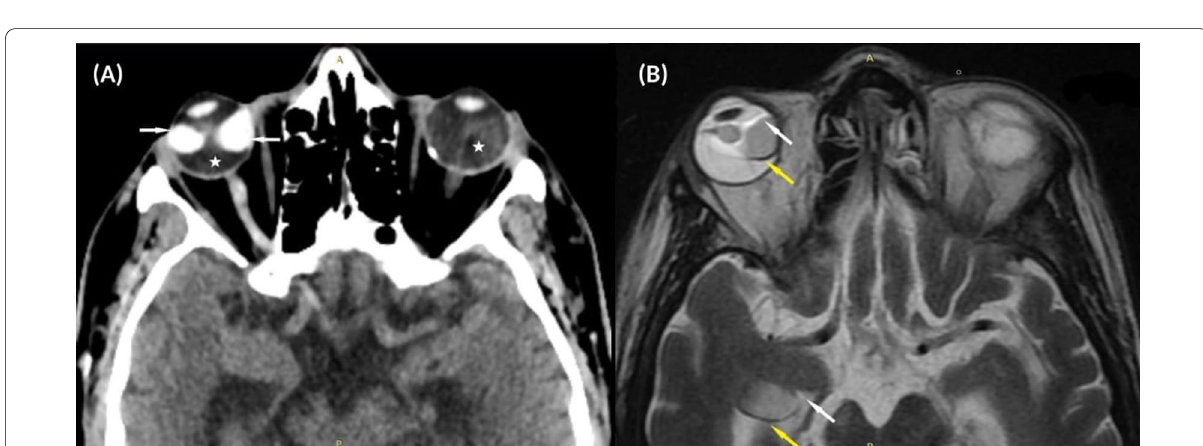
Fig. 3 A Axial NCCT image of bilateral orbits shows silicone oil globules in the right vitreous chamber (arrows) and silicone oil tracking along the right optic nerve sheath. Also, note the partially treated retinal detachment on the right side and an untreated total retinal detachment on the left side (asterisks). B Axial T2W MR image of the right globe shows chemical shift artefact at the interface of the silicone oil with the vitreous chamber, seen as thin curvilinear hyperintense band anteriorly (white arrows) and thin hypointense band posteriorly (yellow arrows). Intraventricular silicone oil globule located within the right temporal horn (which is not seen in the prior CT image, owing to its mobile nature) showing chemical shift